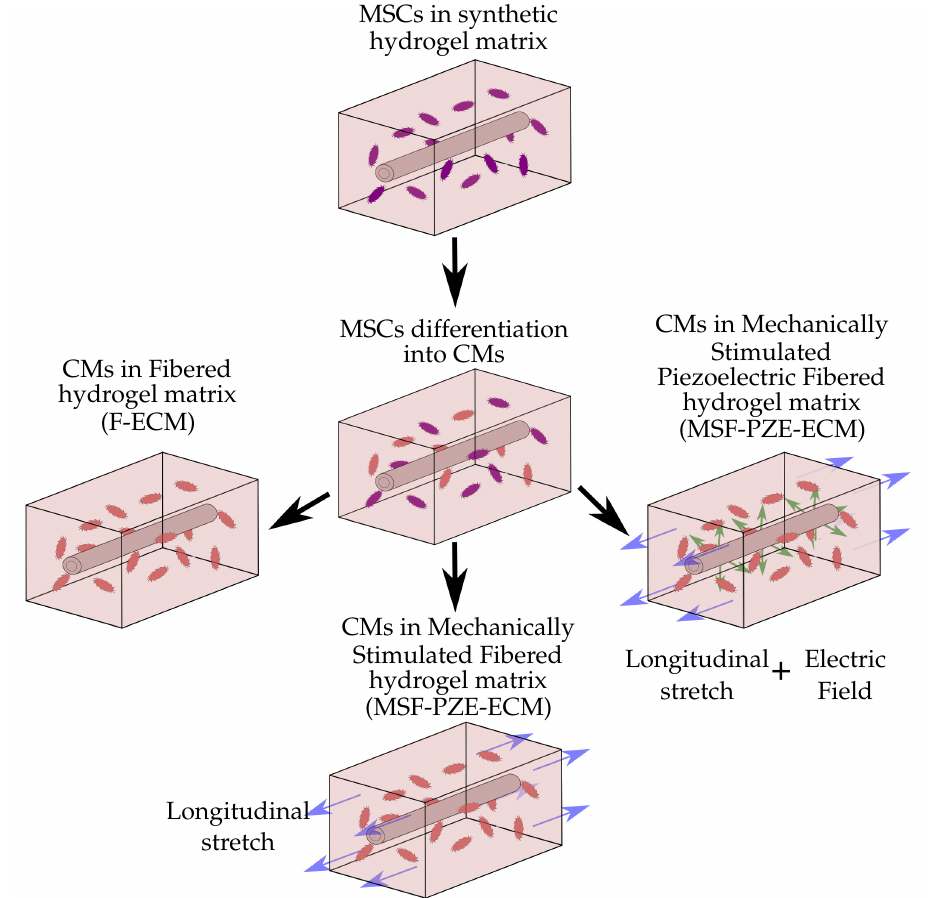
Figure 6. Schematic representation of the experiment setup. Cells are randomly seeded in a 20 kPa stiffness synthetic hydrogel matrix. Cell behavior has been studied under different stimuli, which include ECM stiffness, externally applied force, and electric field stimulus. For all cases, an initial phase of MSCs differentiation into MCs is